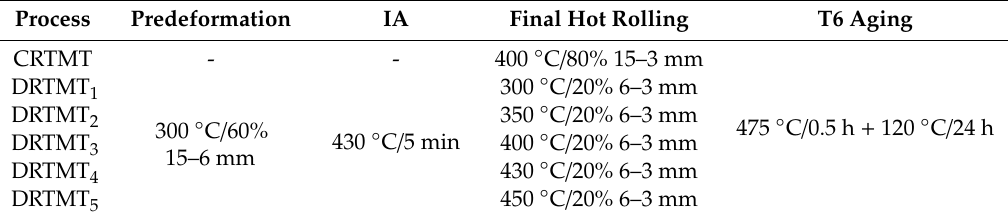
Table 1. Specific parameters of TMTs.